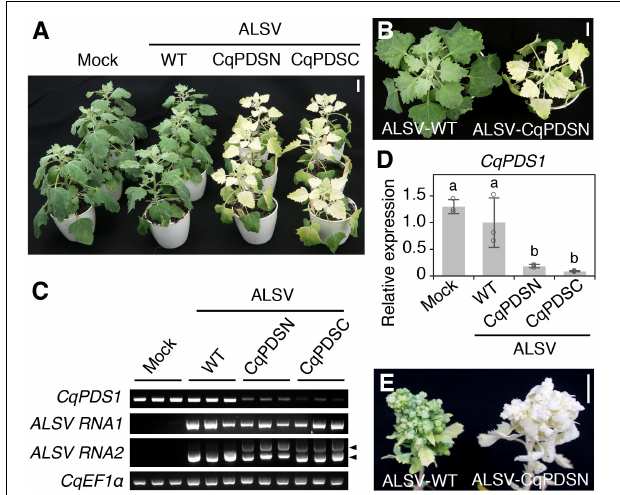
FIGURE 1 | ALSV induces silencing of CqPDS1 genes in quinoa. (A) A representative image of plants (inbred Iw line) at 14 dpi with mock buffer, ALSV-WT, ALSV-CqPDSN, and ALSV-CqPDSC. Three plants were used per inoculum. Scale bar represents 2 cm. (B) Top view of representative plants at 14 dpi with ALSV-WT and ALSV-CqPDSN. Scale bar represents 2 cm. (C) Semi-quantitative RT-PCR of CqPDS1 , ALSV RNA1, and RNA2 in the uninoculated upper leaves of plants at 14 dpi with mock, ALSV-WT, ALSV-CqPDSN, and ALSV-CqPDSC. Quinoa elongation factor 1 α ( CqEF1 α ) was used as an internal control. Arrowheads indicate the positions of recombinant ALSV RNA2 with the trigger sequence (top) and WT RNA2 without the trigger sequence (bottom). (D) RT-qPCR quantification of CqPDS1 transcripts in the uninoculated upper leaves of plants inoculated with the indicated inocula. Data were normalized to the 18S ribosomal RNA ( 18S rRNA ) levels and are shown as means ± SD ( n = 3). Different letters indicate significant differences by a Tukey’s HSD test ( p < 0.05). (E) A representative image of flower buds of quinoa plants at 8 wpi with ALSV-WT and ALSV-CqPDSN. Scale bar represents 1